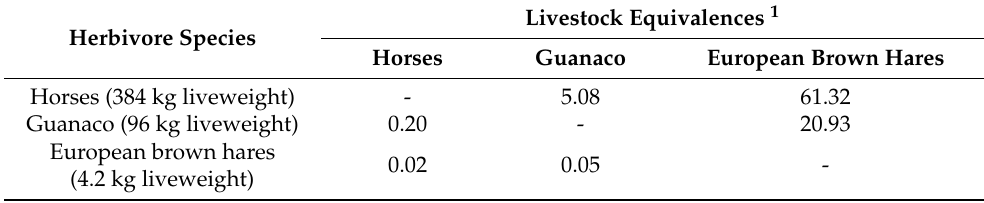
Table 4. Livestock equivalences between horses, guanacos, and European brown hares grazing high mountain ranges of the Region of Coquimbo,